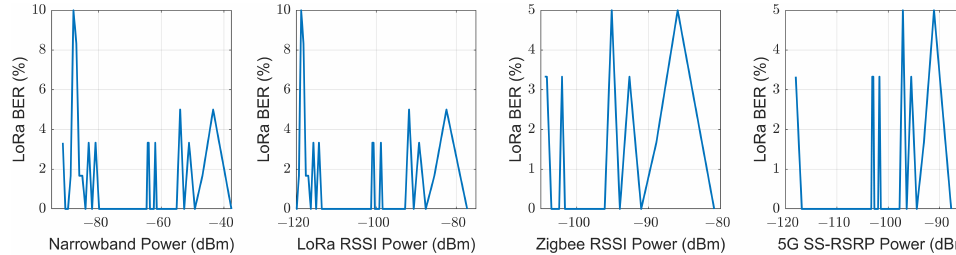
Figure 15. Comparison of empirical LoRa BER with the estimated received power for each technology.